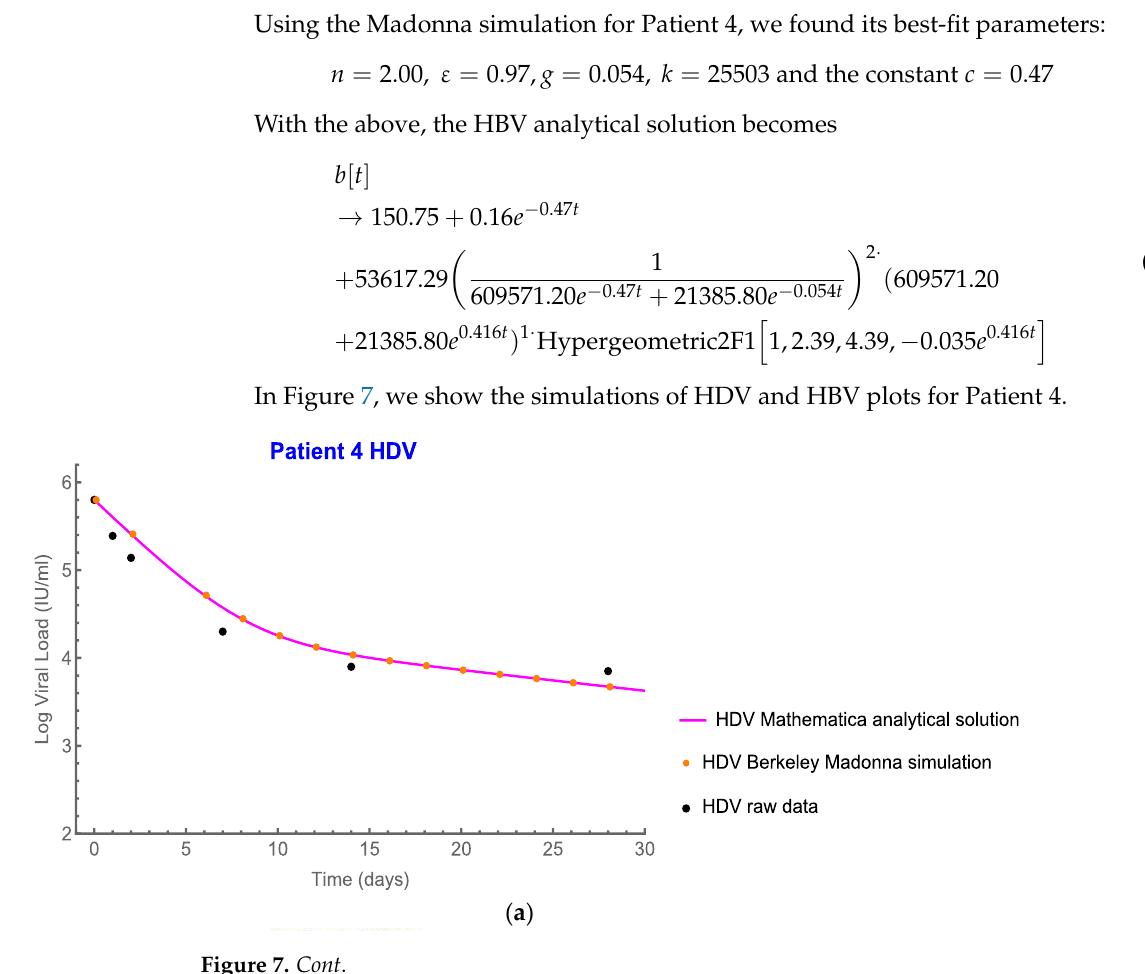
( b ) Figure 7. ( a ) shows the HBV Mathematica analytical solution (i.e., Equation (15) herein), HBV Berke- ley Madonna fit for Patient 4, which is a result of fitting the modified model with measured data using Berkeley Madonna 7. ( b ) follows a similar approach as conducted in 7a but for HDV using D. Using the Madonna simulation for the newly simulated Patient 5, we found its best- fit parameters: 𝒏 = 𝟎. 𝟖𝟏, ɛ = 𝟎. 𝟗𝟕, 𝒈 = 𝟎. 𝟎𝟐𝟏, 𝒌 = 𝟏𝟕𝟏𝟔𝟓𝟒𝟒 𝐚𝐧𝐝 𝐭𝐡𝐞 𝐜𝐨𝐧𝐬𝐭𝐚𝐧𝐭 𝒄 = 𝟎. 𝟒𝟕 With the above, the HBV analytical solution becomes